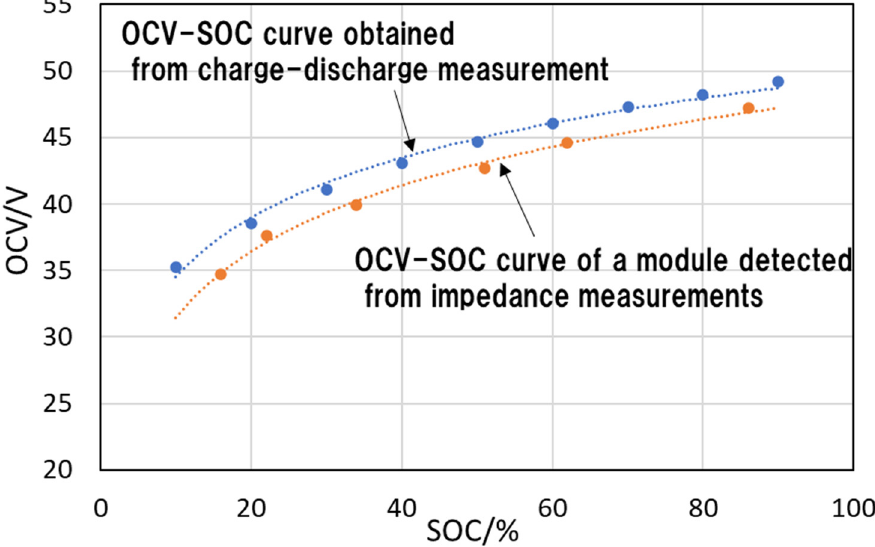
Figure 4. Module output voltage vs. impedance Cole–Cole plot measurement results.